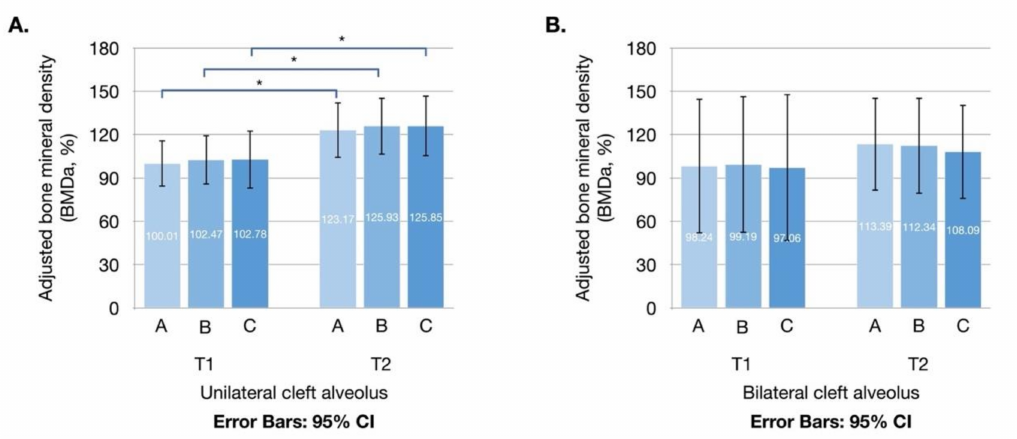
Figure 5. Error bars of adjusted bone mineral density (BMD a ) of grafted tissue at T1 and T2 in individuals with ( A ) unilateral alveolar cleft and ( B ) bilateral alveolar cleft. Significant differences among the three methods were observed in unilateral alveolar cleft ( n = 33), but no significant differences among the three methods ( p = 0.176 for all three methods) were observed in bilateral alveolar cleft. Stars indicate significant differences in BMD a between T1 and T2: *, p < 0.05.